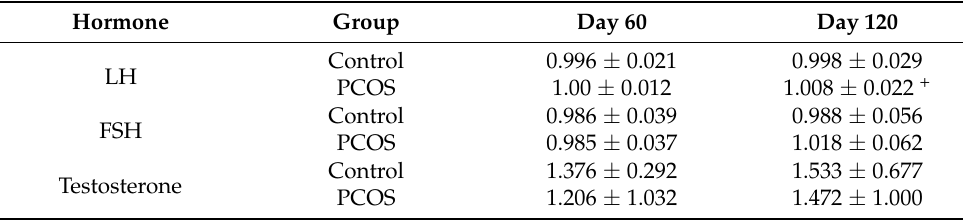
Table 2. Relative changes (vs. Base) in the FSH, LH, and testosterone levels in Control and polycystic ovary syndrome (PCOS) group.